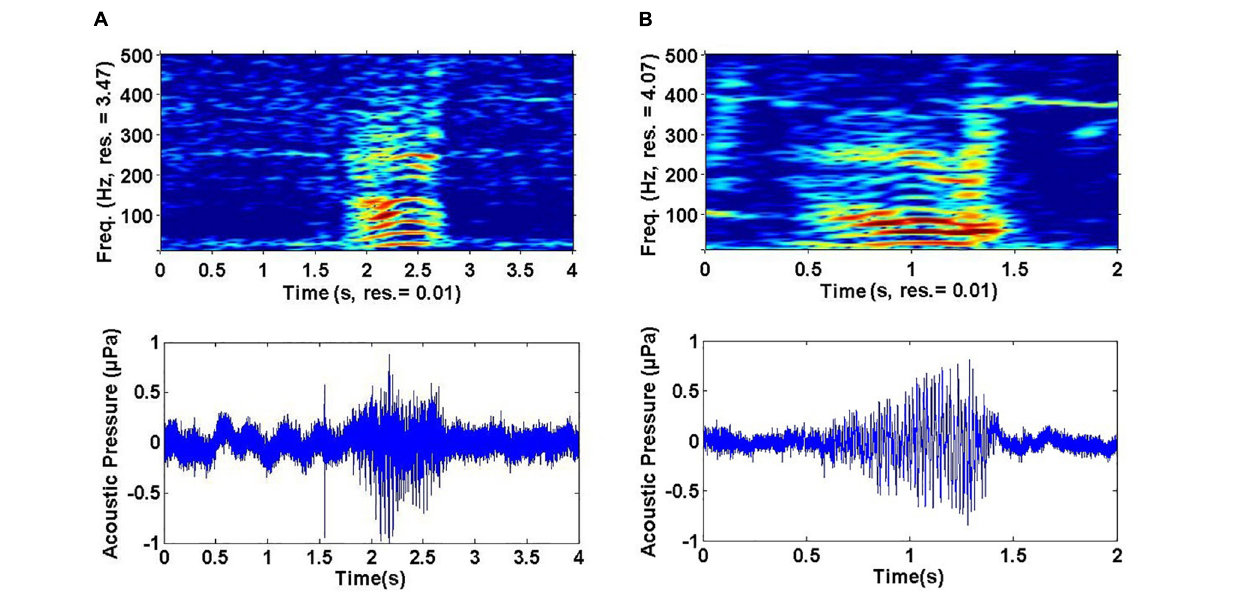
Frontiers in Marine Science |